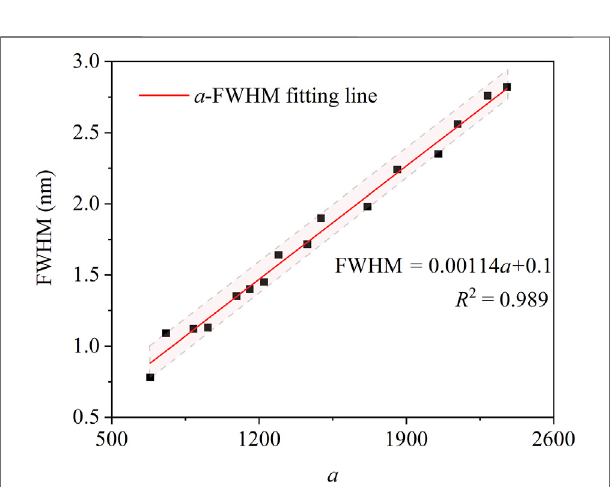
FIGURE 8 | Fitting relationship between the FWHM of FBG and the gradient parameters a .